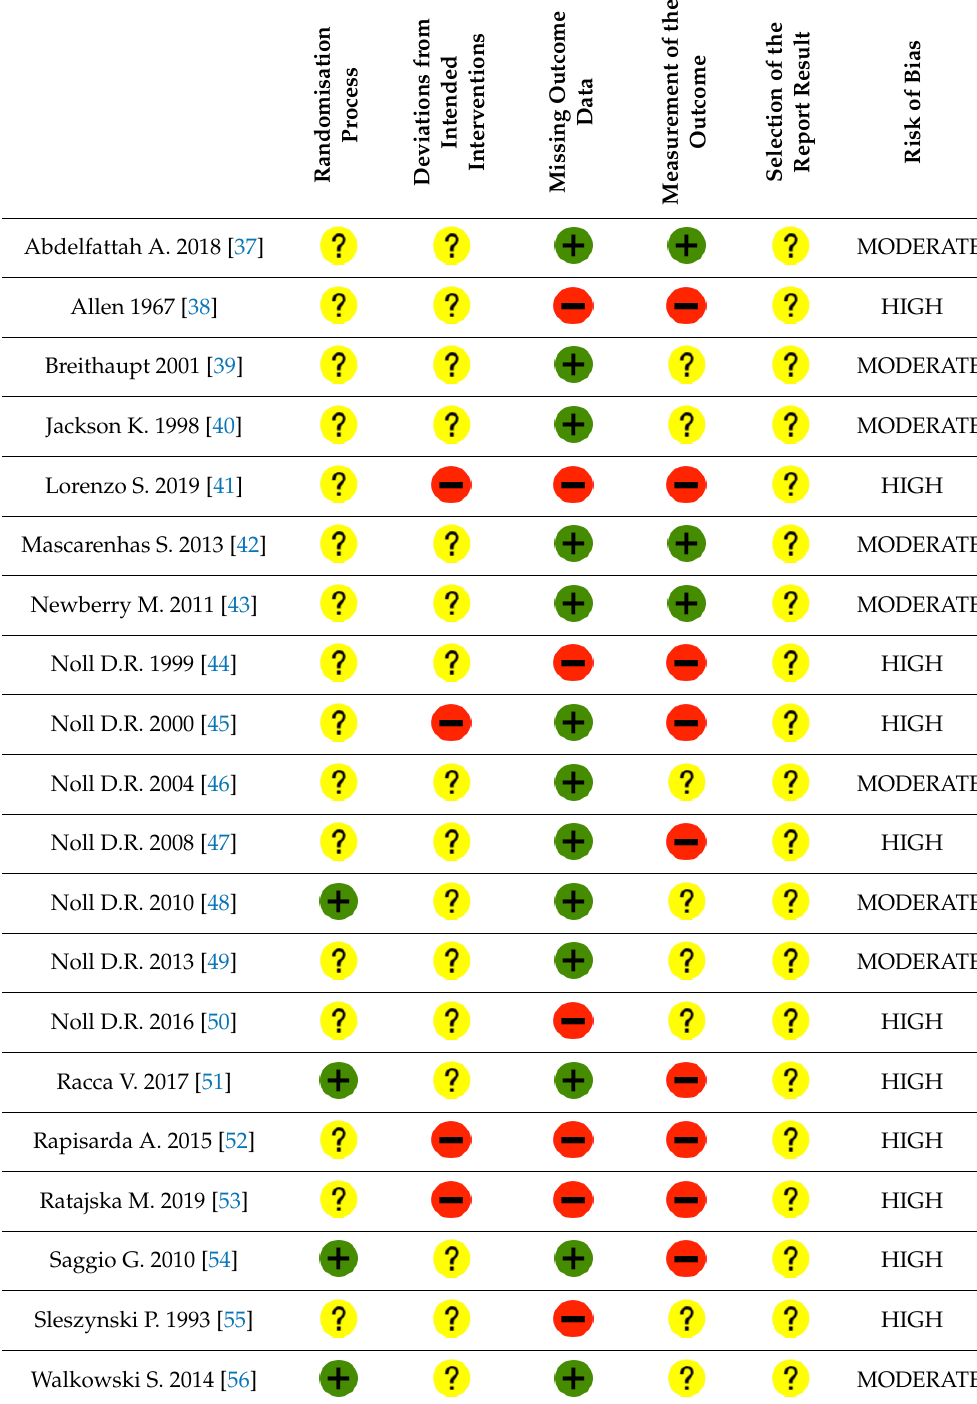
Table 3. Synthesis of the risk of bias assessment on pump